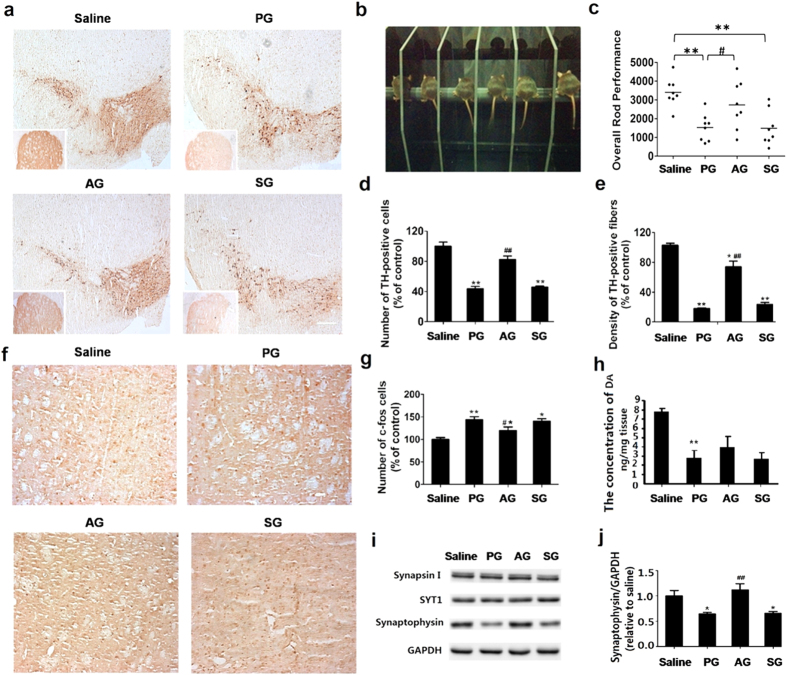
Acupuncture treatment at GB 34 improves exercise performance and protects dopamine neurons in PD mouse.(a) The TH-positive neurons in the SNpc and the TH-positive fibers in the striatum. Scale bar: 200 μm; inset: striatum. (b) Photograph for mice undergoing rota-rod testing. (c) The overall rod performance (ORP) scores for mice in each group (n = 8). (d) TH-positive neurons counts in the mouse SNpc in each group. (e) The optical density of TH-positive fibers in the mouse striatum in each group (n = 5). (f) Immunohistochemistry staining of c-fos in the striatum. (g) The number of c-fos positive cells in the striatum (n = 5). (h) The level of dopamine in the striatum. (i) Immunoblot for proteins involved in synaptic transmission in the striatum. (j) The optical density of synaptic Proteins. In all panels,*P < 0.01, **P < 0.01 compared with SG. #P < 0.05, ##P < 0.01 compared with PG.